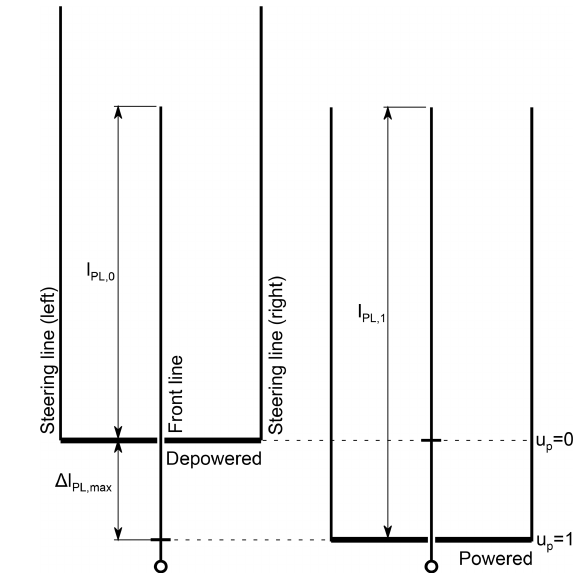
Figure 4. Limiting states of the “linear power” maneuver.